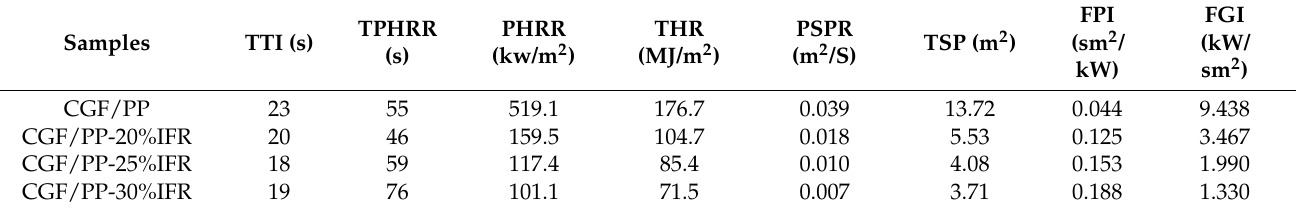
Figure 6. Total heat release rate curves of composites with different IFR content.